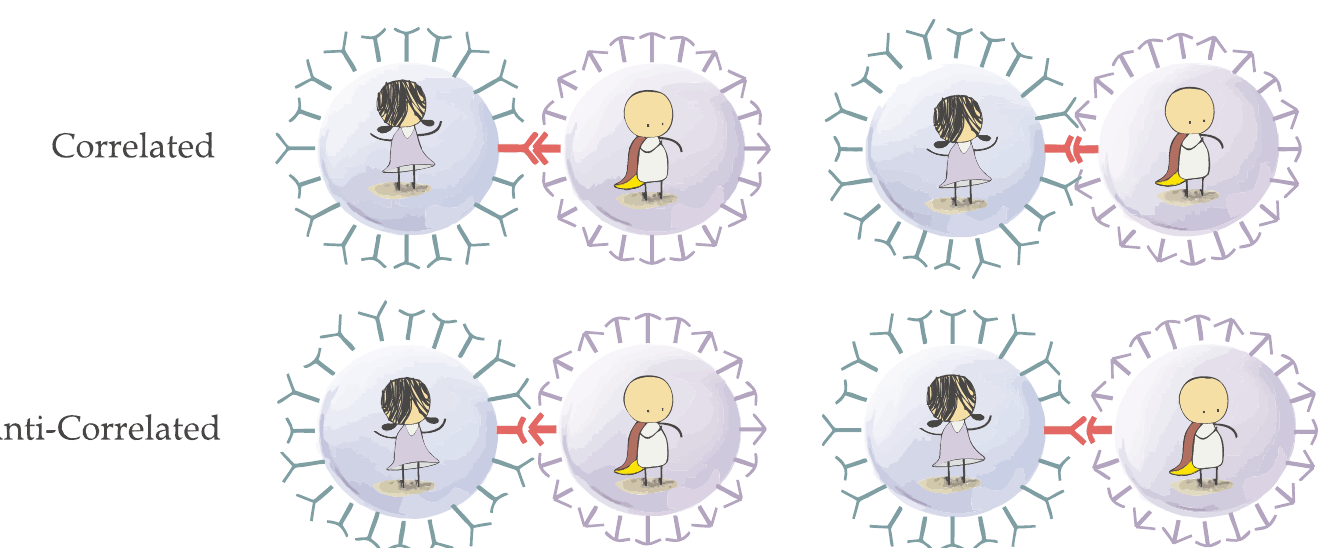
Fig 2. Four types of interactions between a cell (Alice) and a virus (Bob). The top row illustrates successful bindings when the cell receptors correlate with the virus ligands, C = V = 1 or C = V = − 1. The bottom row shows unsuccessful binding attempts when the opposite occurs, C 6¼ V . This setting is reminiscent of the Alice-Bob coordination game underlying bipartite Bell